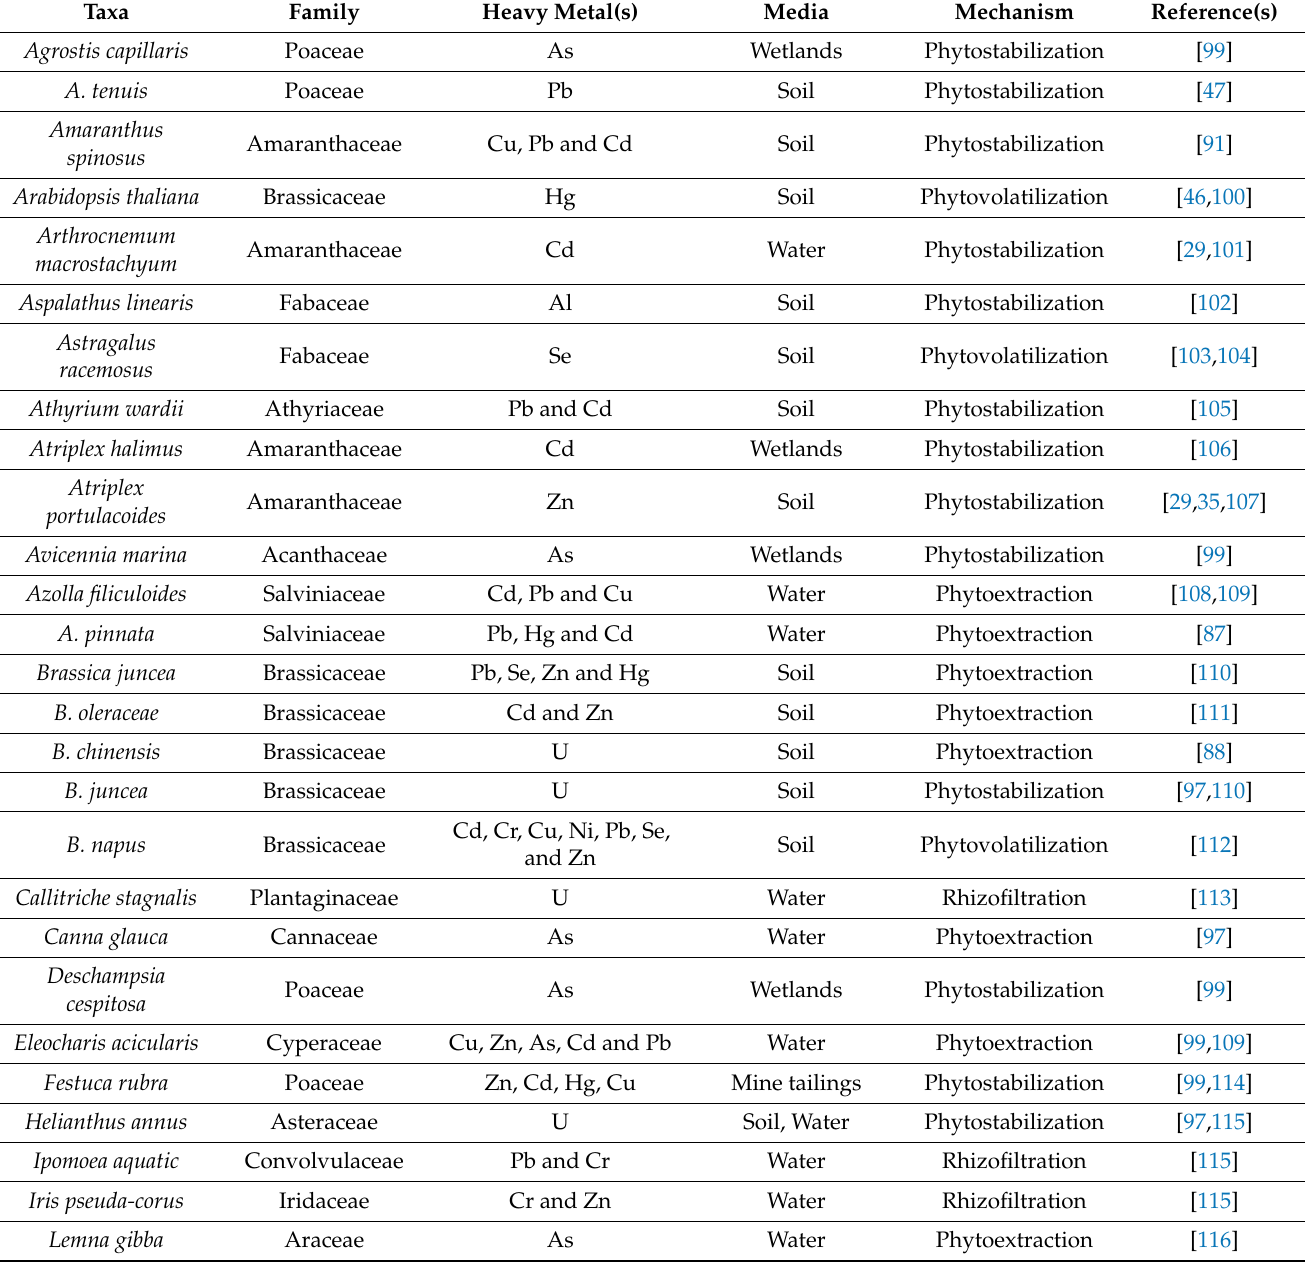
Table 2. List of the plant species reported for their role in phytoremediation of varied